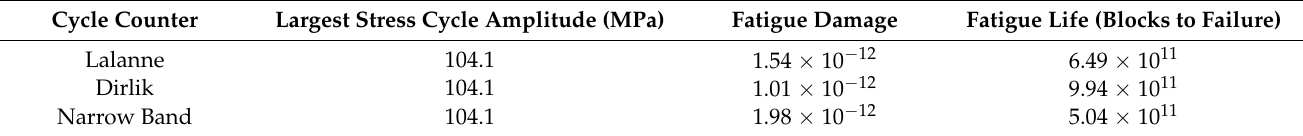
Table 9. Fatigue life results for the 0.50 mm lattice blade.